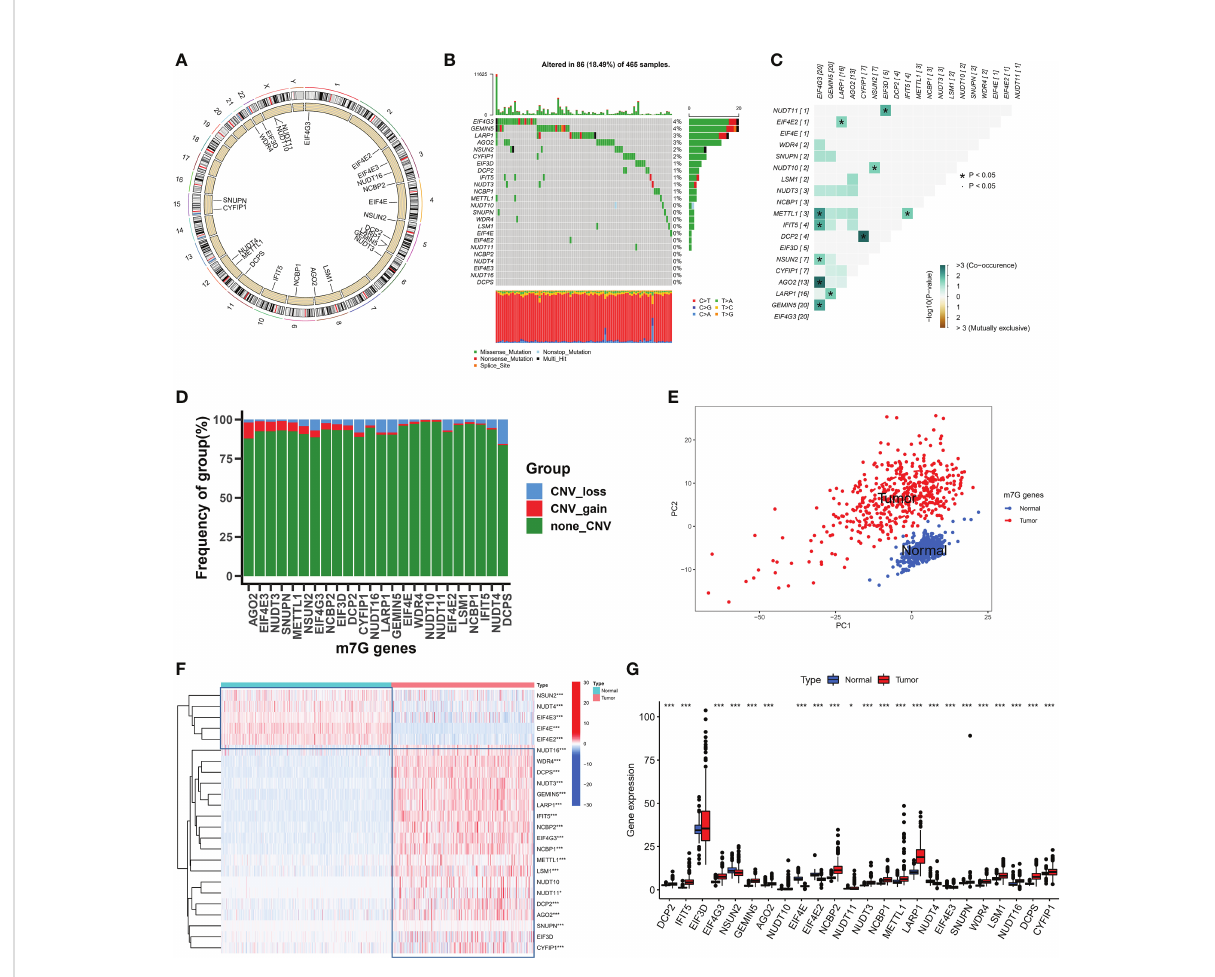
FIGURE 1 The landspace of genetic and variation of 24 m7G genes in SKCM. (A) The location of 24 m7G genes on chromosomes. (B) The mutation frequency of 24 m7G regulators in 465 patients, with each color representing the mutant types. Numbers on the right part of the fi gure represent the mutation frequency. (C) Co-occurrence and exclusion of 24 m7G genes mutations. Green color represents co-occurrence, and yellow color represents exclusion. (D) The CNV frequency of 24 m7G genes. The red color represents ampli fi cation as well as the blue color represents deletion. (E) Principal component analysis of m7G genes. (F, G) The expression levels of 24 m7G genes in normal and tumor tissues. (*p < 0.05;***p <